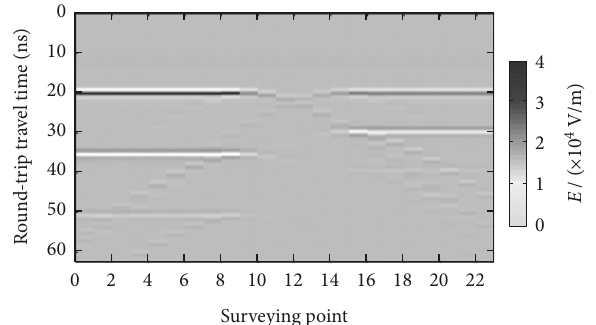
Figure 2: Forward simulation results of the electric field com- ponent (after removing direct waves), where ( E ) refers to “electric field